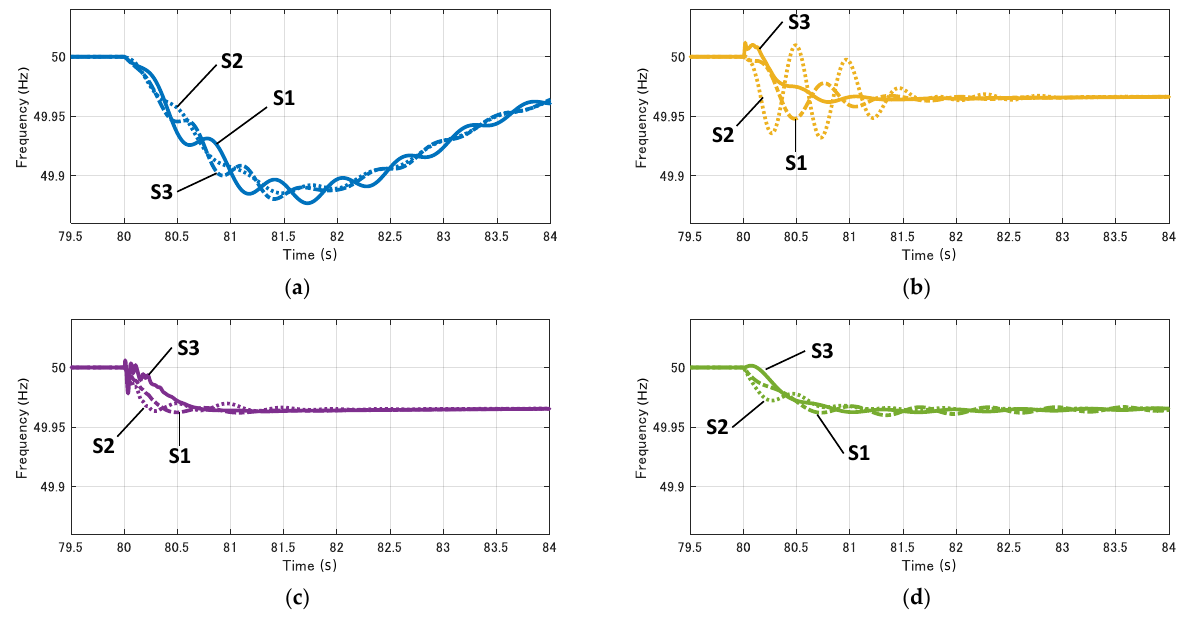
Figure 10. Simulation results of the cases for the 80% IBR penetration rate. ( a ) COI frequency, ( b ) the deviation of the active power output of S3, ( c ) the deviation of the voltage at the POI of the IBR, and ( d ) the deviation of the reactive power output of S3.